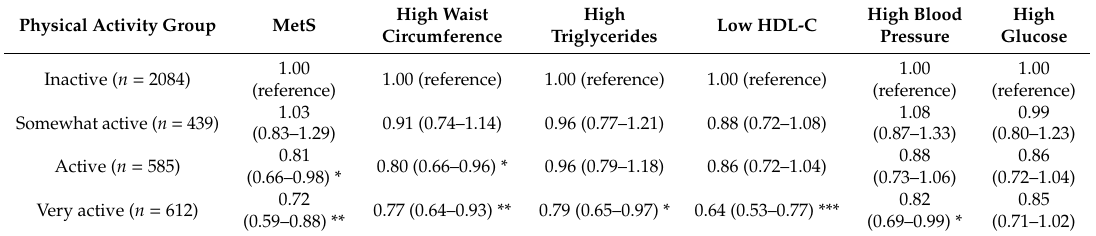
Table 5. Odds ratio (95% CI) for MetS and MetS components according to physical activity